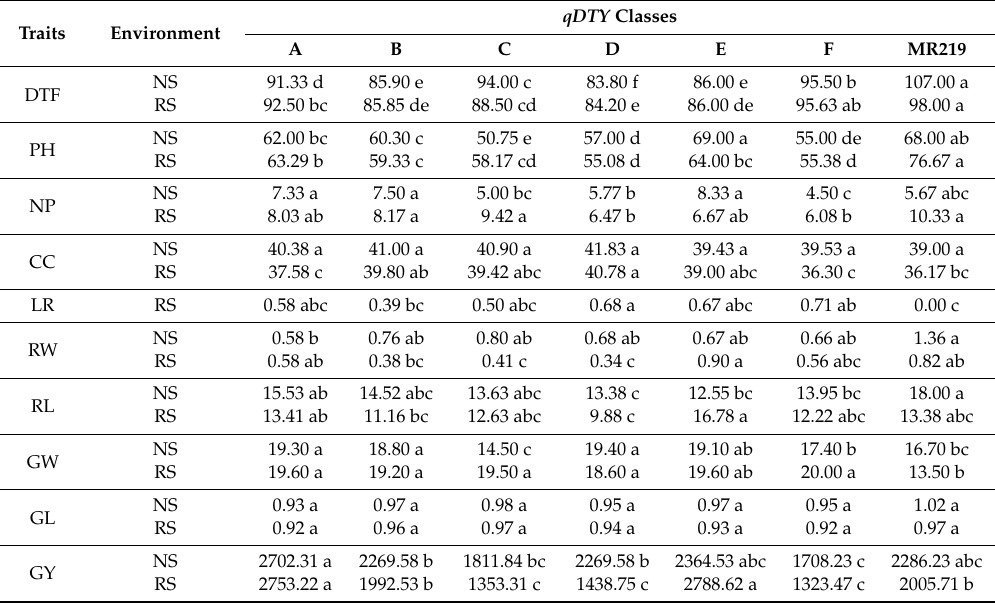
Table 2. Mean values of traits of MR219 qDTY classes under NS and